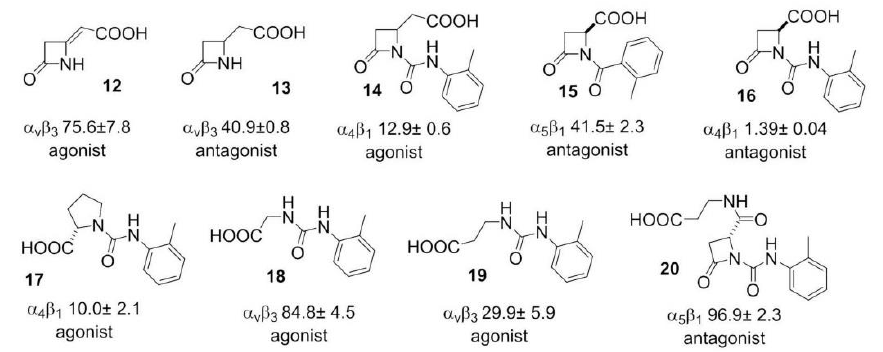
Figure 4. Examples of β-lactam based agonist or antagonist integrin ligands utilized for Structure-Activity Relationships (SAR) and modeling analysis of agonism vs. antagonism; the affinities (nM) for the specified integrins are also shown.